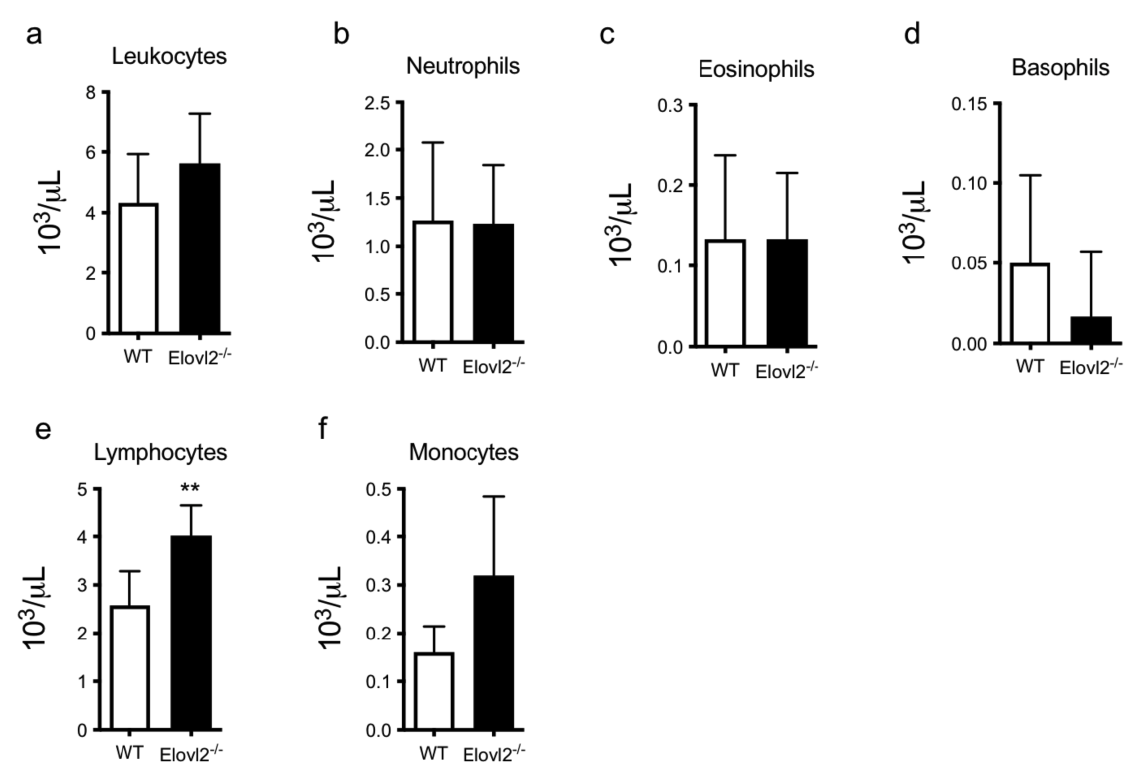
Figure 1. Cell count in peripheral blood of ( a ) total leukocytes, ( b ) neutrophils, ( c ) eosinophils, ( d ) basophils, ( e ) total lymphocytes, and ( f ) monocytes in WT and Elov2 −/− mice. ** p < 0.01. 2.3. DHA Deficiency Exacerbates the Pro-Inflammatory Responses of T Lymphocytes In